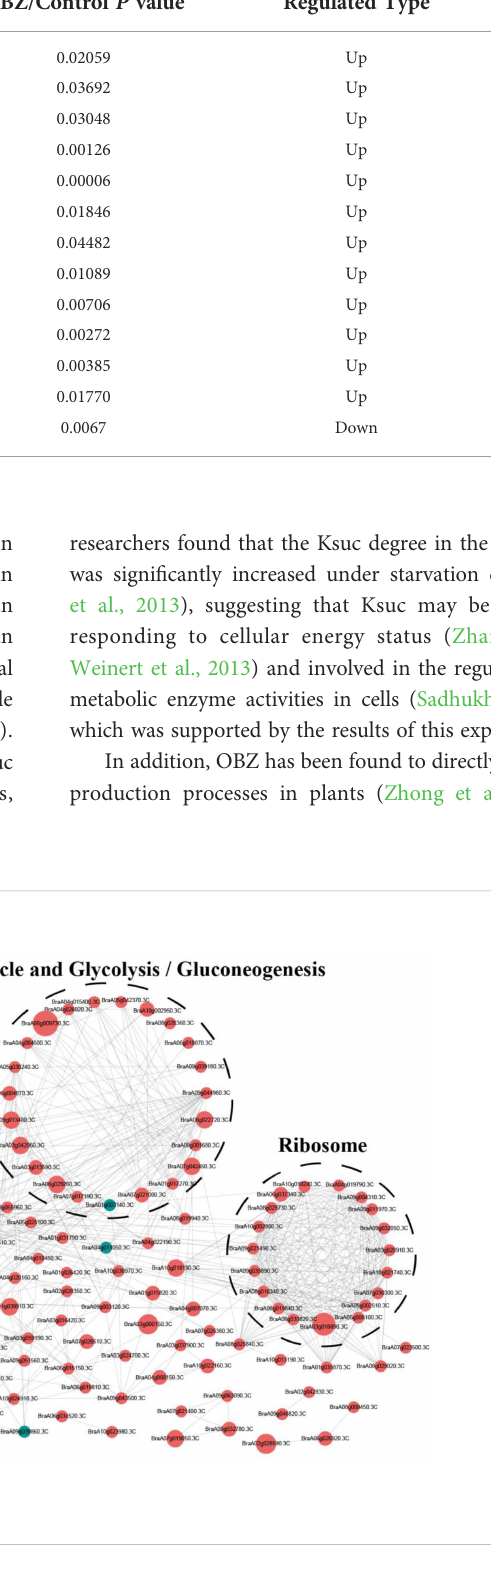
TABLE 3 Differentially modi fi ed sites (modi fi ed proteins) for biosynthesis of amino acids. Protein accession OBZ/Control Ratio